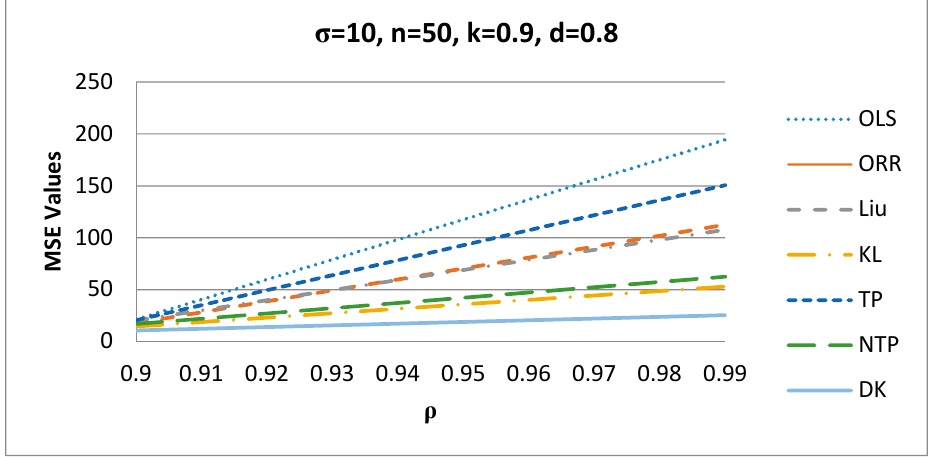
Figure 2. MSE values versus n values.